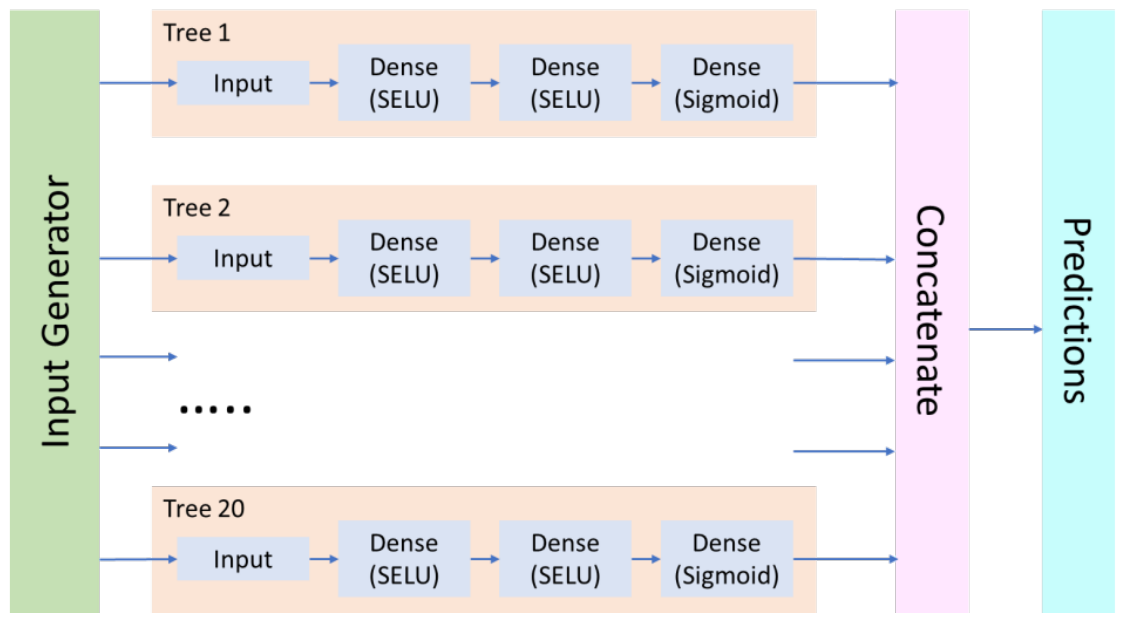
Figure 2. Basic architecture of the “forest” neural network model.